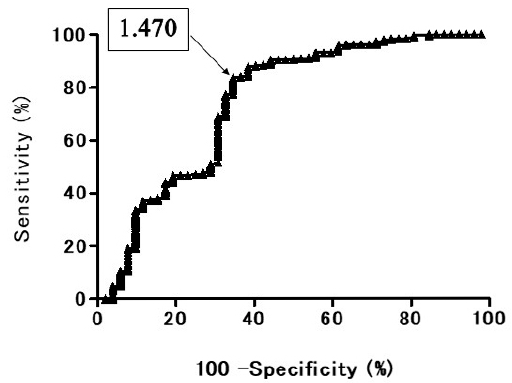
Figure 1. Receiver operating characteristic (ROC) curve shows the diagnostic performance of diffusion-weighted magnetic resonance imaging (DWI) for distinguishing benign pulmonary nodule and mass (BPNM) from lung cancer. Area under the ROC curve 74.8%. Apparent diffusion coefficient (ADC) = 1.470 × 10 − 3 mm 2 /s, sensitivity 84.2%, specificity 63.5%.